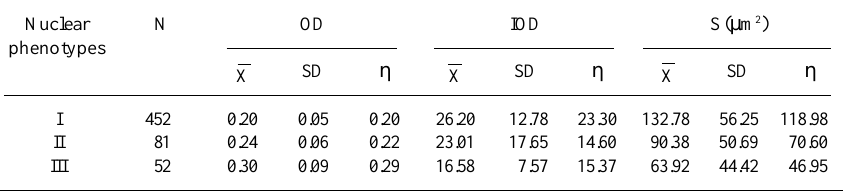
Table I - Video nuclear image parameters for Feulgen-stained V79